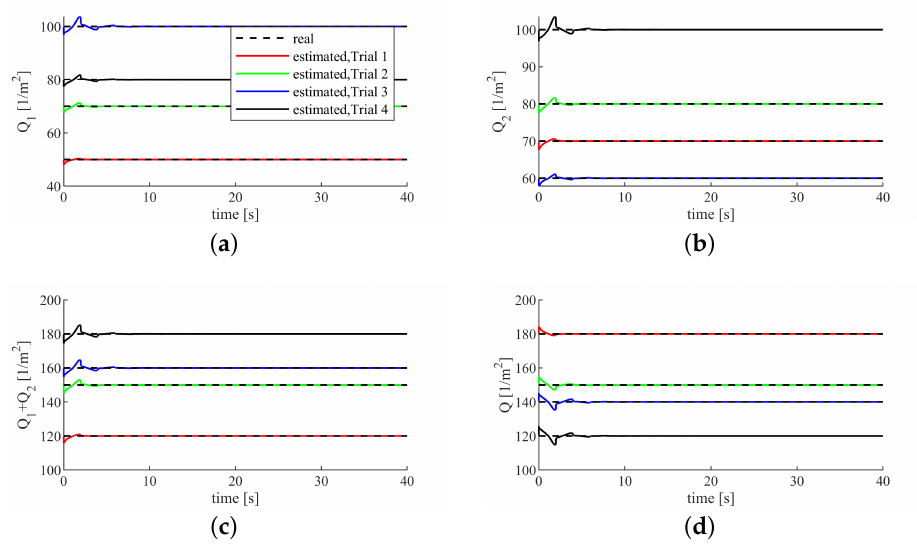
Figure 8. Humans’ state weights. ( a ) the state weight of the human 1. ( b ) the state weight of the human 2. ( c ) the sum of the state weights of the human 1 and human 2. ( d ) the state weight of the